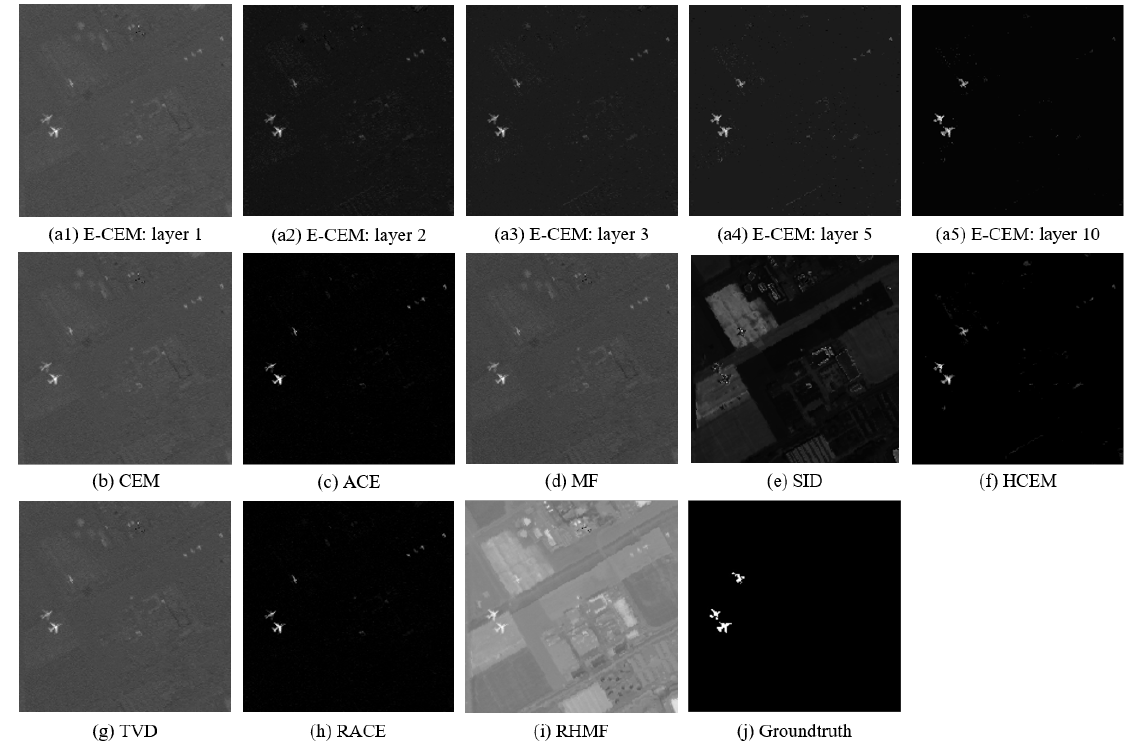
Figure 8. Detection outputs of different algorithms on the AVIRIS San Diego data: First row ( a1 – a5 ): 1st, 2nd, 3rd, 5th and 10th layer of the E-CEM’s outputs. Second row and third row ( b – i ): results of CEM [2], ACE [10], MF [11], SID [9], HCEM [17], TVD [15], RACE [37], RHMF [16] and the proposed E-CEM. ( j ): ground truth. All outputs are normalized to [ 0,1 ] .